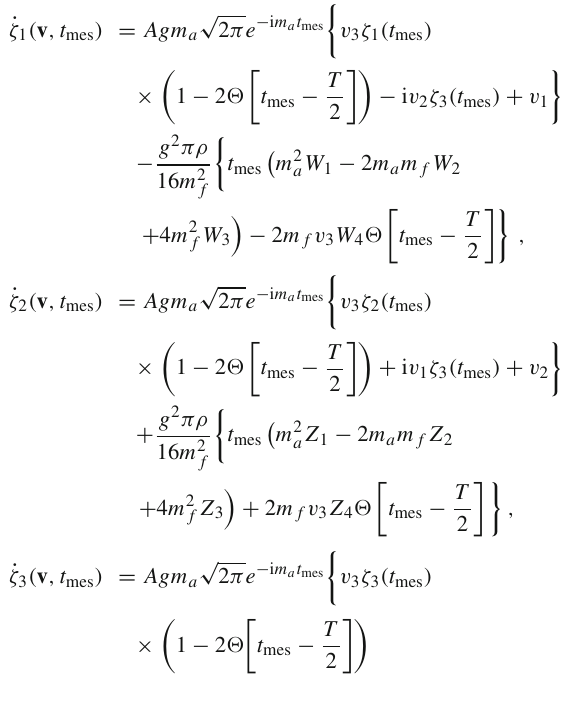
corresponding induced decoherence is